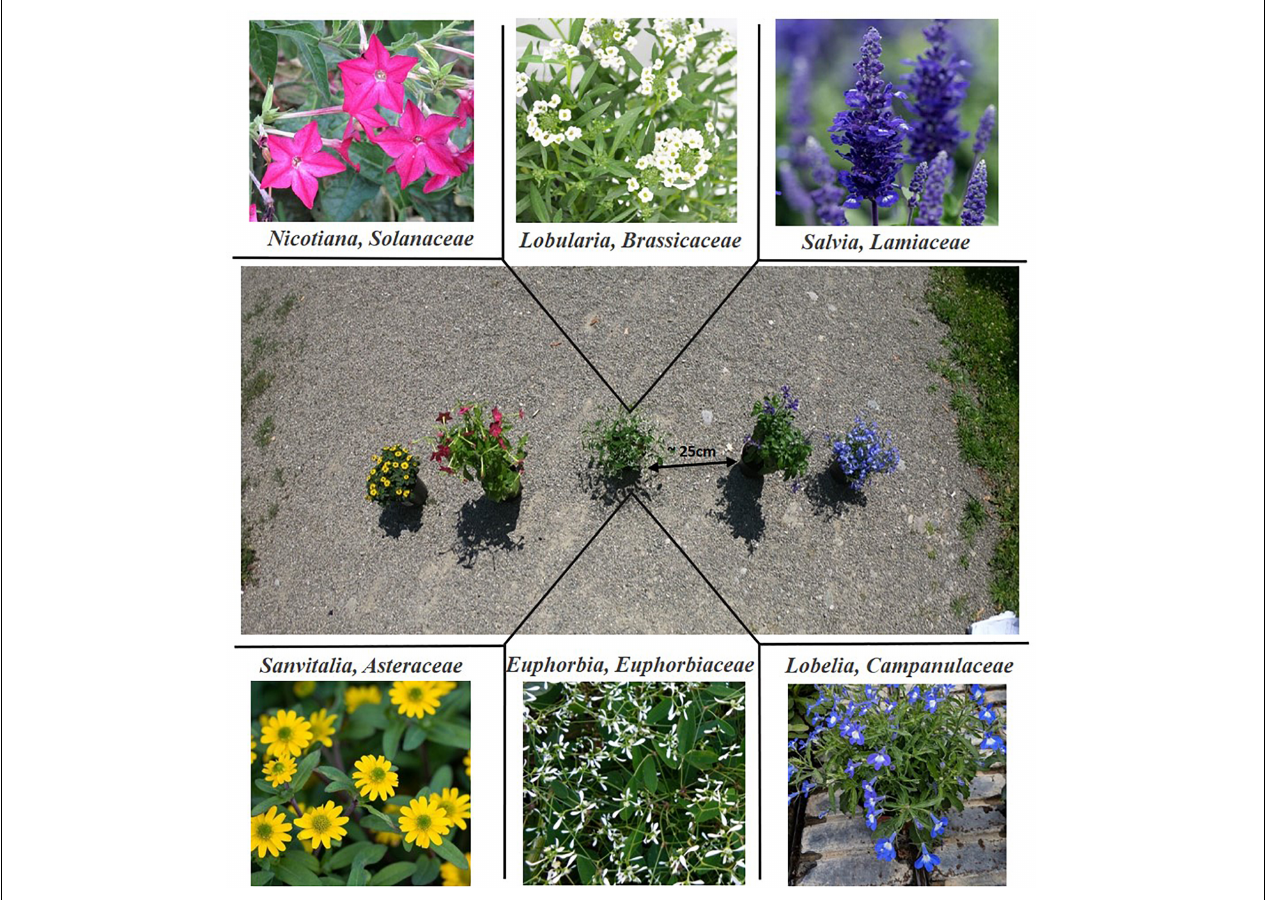
FIGURE 2 | Placement of plant phytometres in Munich Squares. Plants were placed equal distances apart, but the wide-angle lens may distort configuration as pictured here. Only one white flowered plant was used in each sampling period. Lobularia was used in the first round of sampling and was then replaced with Euphorbia in the latter two rounds. Placement order was randomised for each